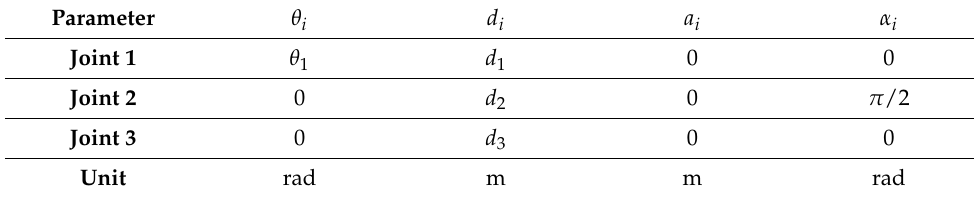
Table 1. Denavit–Hartenberg parameters of cylindrical